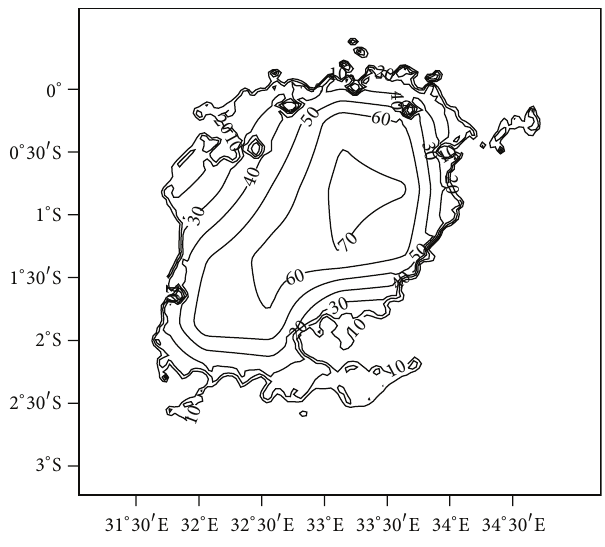
Figure 2: The bathymetry of Lake Victoria.